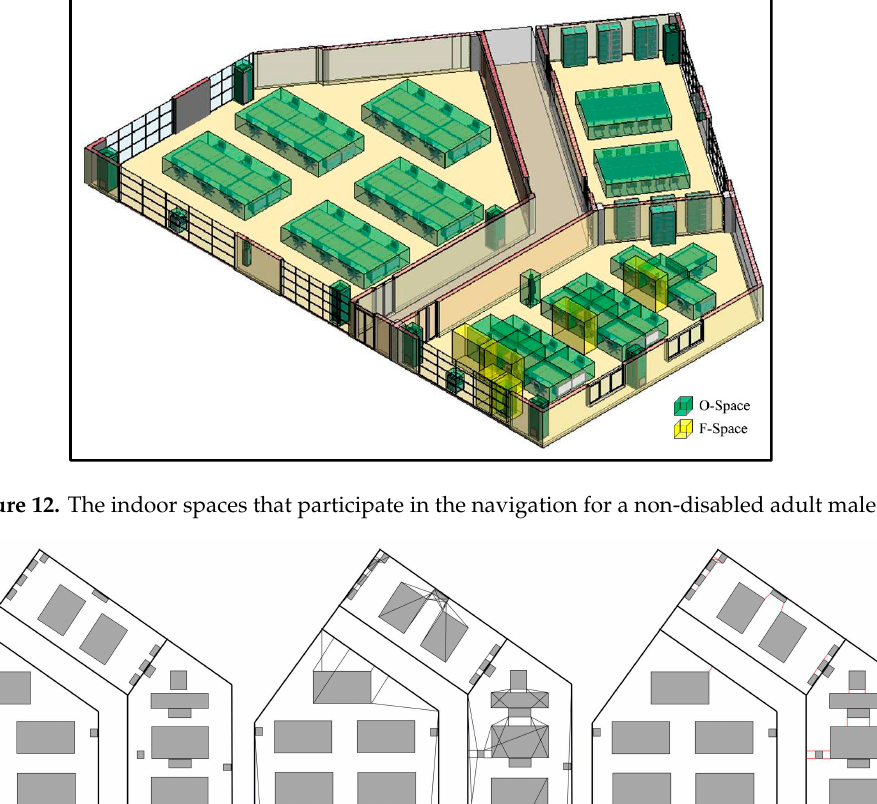
Figure 14. The differences between the generation of the navigable space between the proposed method in this paper and the flexible space subdivision (FSS) framework. ( a ) Inaccessible subspaces and CN-Space generated by the proposed method. ( b ) Partial detail presentation of CN-Space. ( c ) The navigable space generated by the FSS framework. ( d ) Partial detail presentation of the navigable space generated by the FSS framework. 3.2. CN-Space for a Disabled Adult In this subsection, a disabled adult male is considered an indoor navigation agent. This kind of agent usually moves with a wheelchair, so the agent’s O-Space is the space occupied by his body and